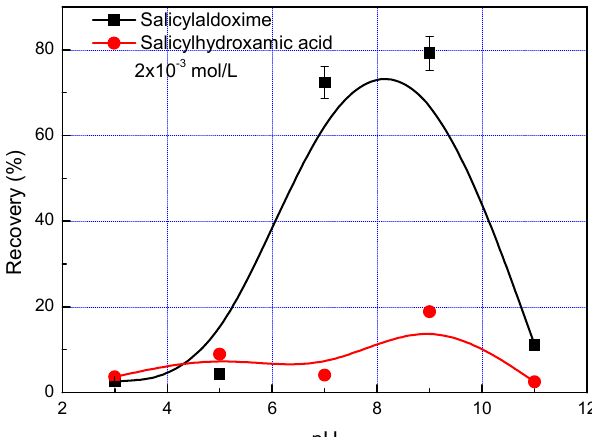
Figure 8. Effect of pH on the flotation of malachite with salicylaldoxime and salicyl hydroxamate collectors.